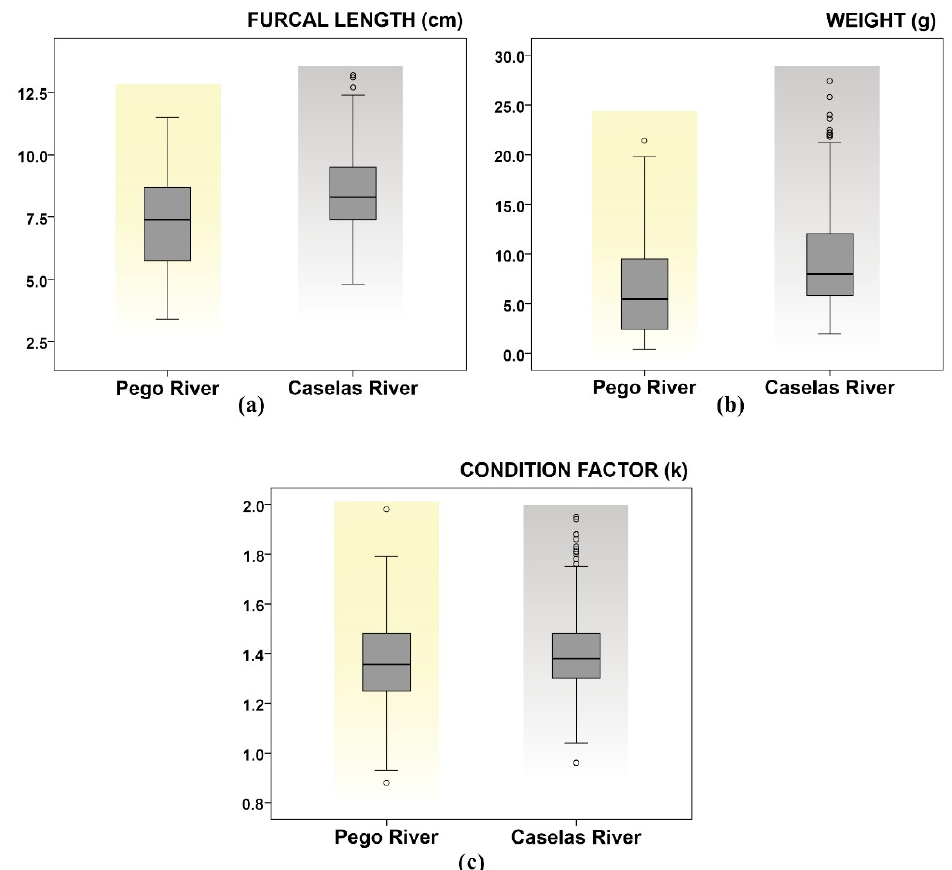
Figure 2. Box plot (median, quartiles, maximum, and minimum) of the ( a ) furcal length, ( b ) weight and ( c ) condition factor in the two studied populations of G. lozanoi.